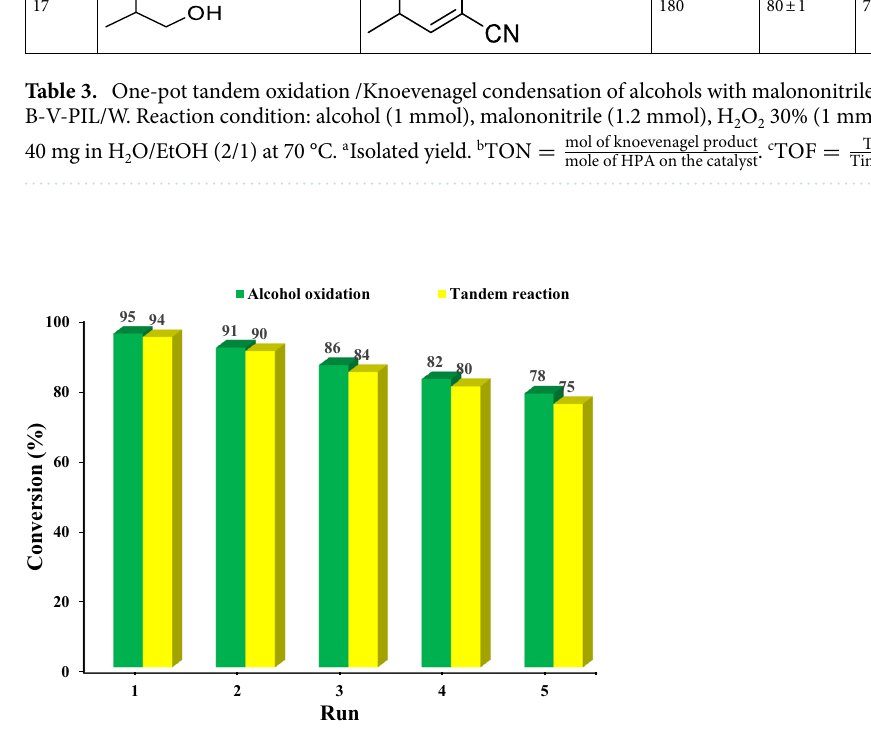
Figure 8. Recyclability of B-V-PIL/W for the model reactions under the optimum reaction